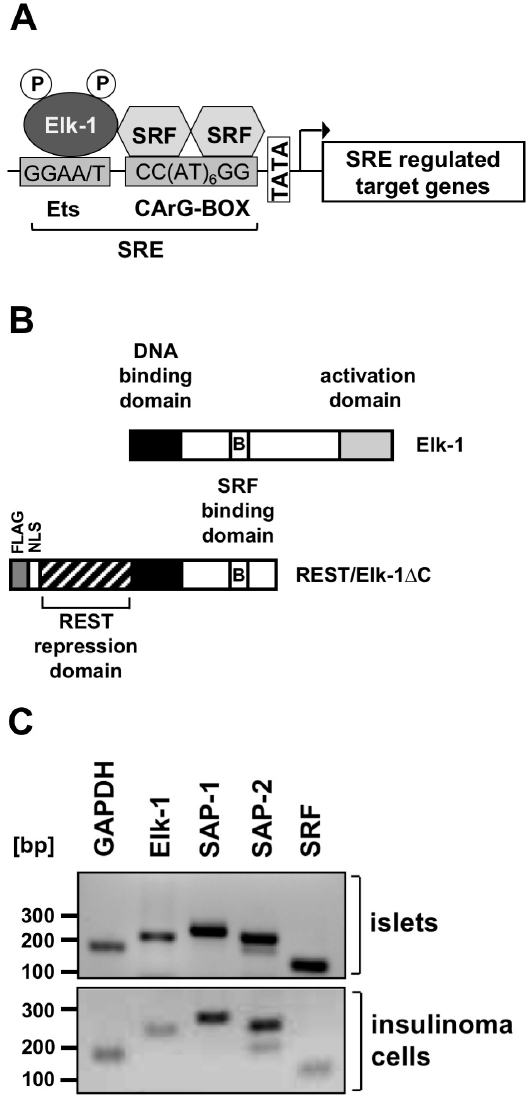
Figure 3. Domain structure of Elk-1 and REST/Elk-1 ∆ C and expression of TCF proteins in pancreatic β -cells and insulinoma cells. ( A ) Schematic representation of the SRE that has interaction sites for Elk-1 and SRF. ( B ) Functional domains of Elk-1 and REST/Elk-1 ∆ C. Elk-1 interacts with the DNA sequence GGAA/T via its DNA binding domain. Elk-1 binds to SRF via the B domain. The C-terminal activation domain contains major phosphorylation sites for the protein kinases JNK, ERK1/2, and p38. ( C ) RT-PCR analysis shows that Elk-1, the related TCF proteins SAP-1 and SAP-2, and the TCF interaction partner SRF are expressed in pancreatic islets and INS-1 insulinoma cells. Expression of GAPDH mRNA is also shown. Reproduced with modifications from ref. [26] with permission from